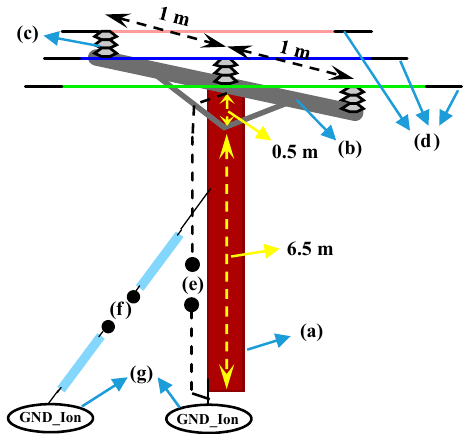
Figure 2. Dimensions and different parts of the medium voltage wood pole for a 3-phase distribution network: ( a ) pole, ( b ) cross arm, ( c ) insulator, ( d ) overhead lines, ( e ) lead wire (used for grounding), ( f ) guy wire, and ( g ) earthing system.